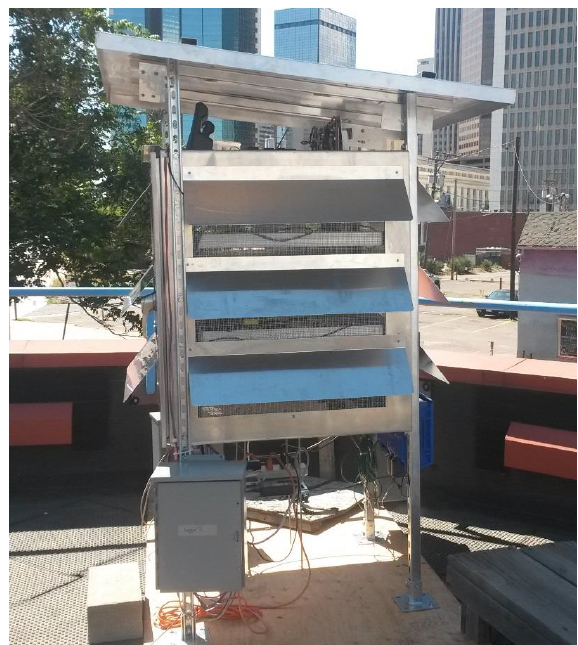
Figure 1. Sensor deployment